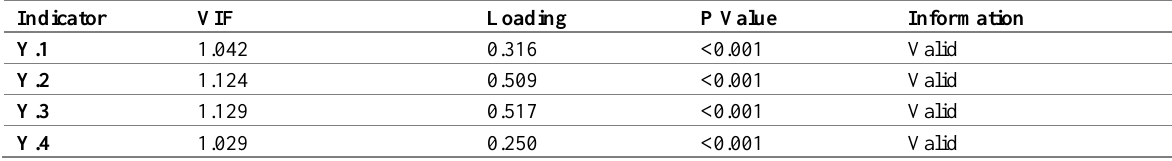
Table 3: Table of Formative Construct Convergent Validity Test Results